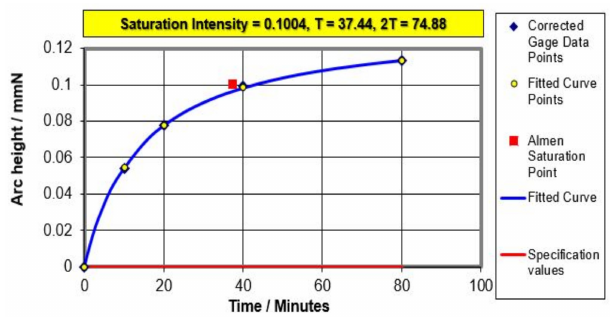
Figure 4. Example of saturation curve.